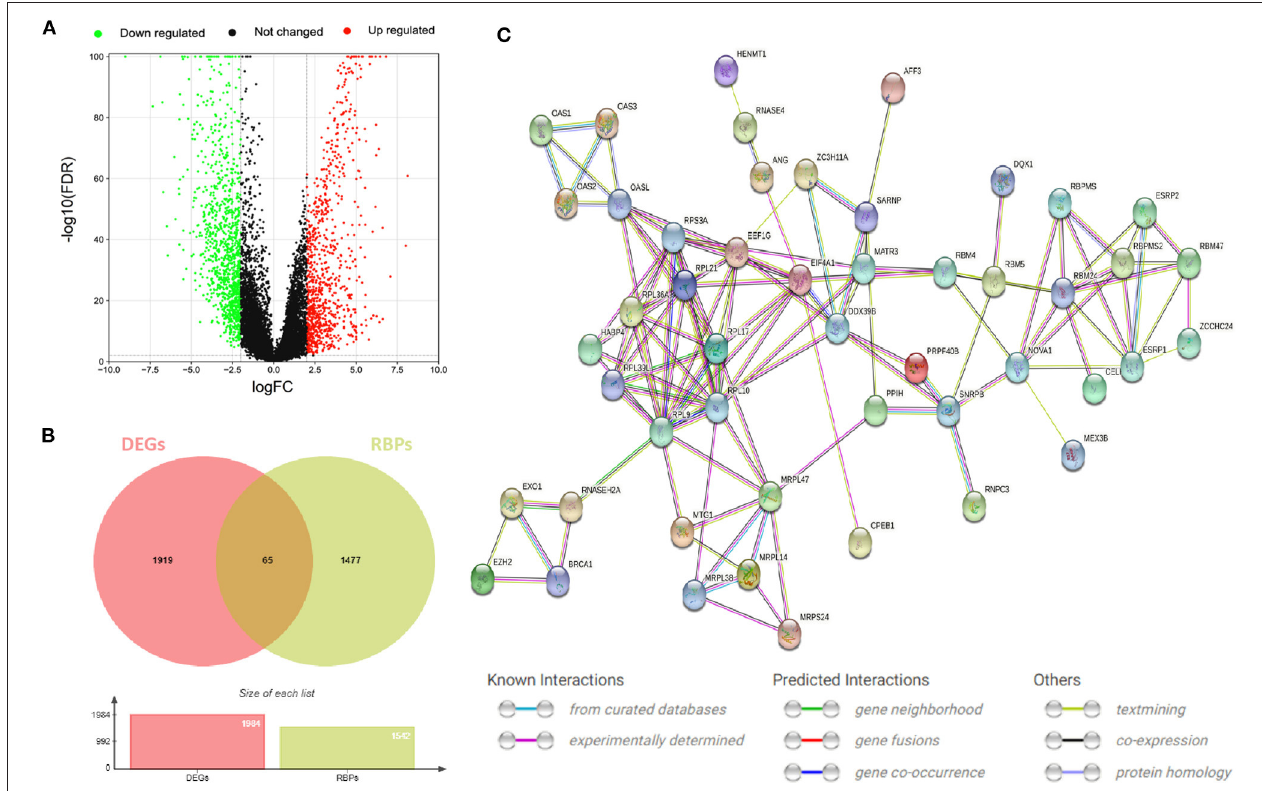
FIGURE 2 | RBPs differentially expressed in CESC. (A) Volcano map of DEGs differentially expressed between CESC and normal tissues. The selection criteria were |logFC| > 2 and FDR value < 0.01 (red and green represent up-regulated and down-regulated genes, respectively). (B) Wayne diagram of differentially expressed RBPs in CESC. (C) Protein interaction network differentially expressing